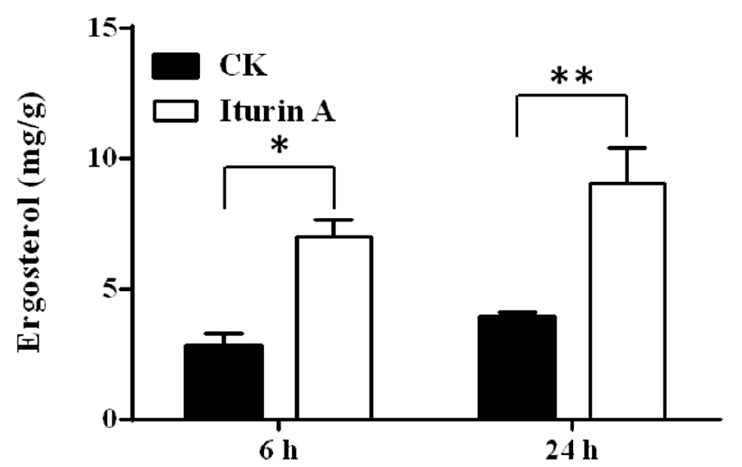
Figure 7. Effects of iturin A on the ergosterol content of mycelia at 6 h and 24 h. *, significantly different at p < 0.05; **, significantly different at p < different at p < 0.05; **, significantly different at p < 0.01.